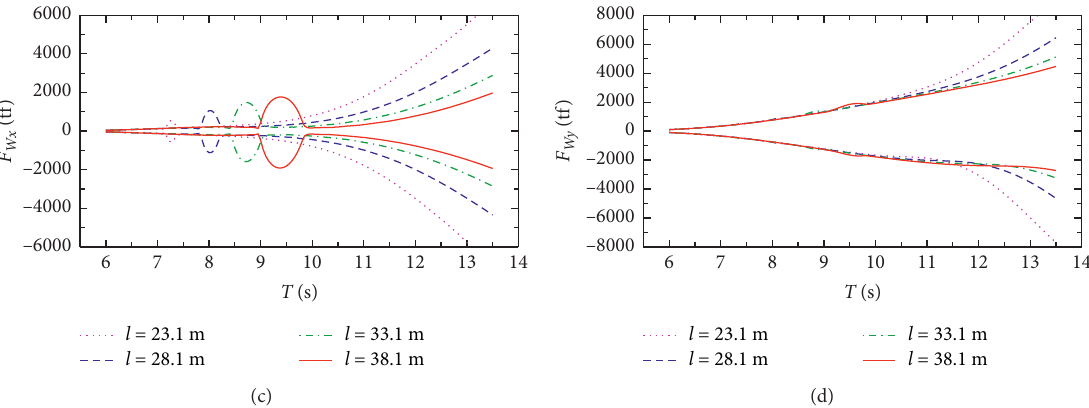
Figure 13: Relevant physical quantities are changed by various wave periods Twith different lengths of mooring cable (l): (a) the horizontal displacement of the tube X s , (b) the mooring cable tension F T , (c) the horizontal wave forces F Wx , and (d) the vertical wave forces F Wy ( s � 0.04, BWR � 2.6; d � 80m).